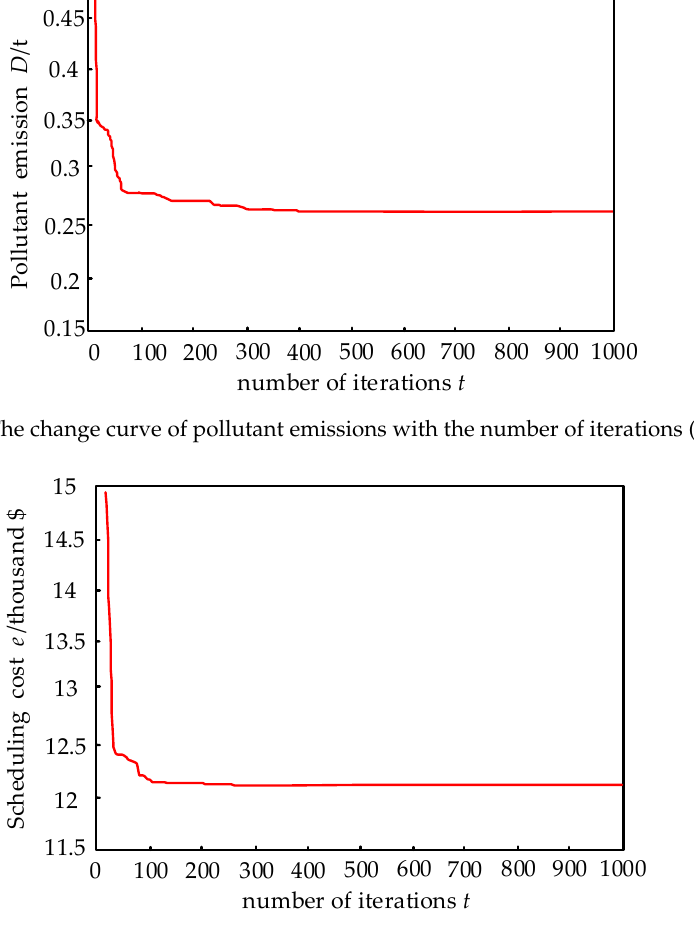
Figure 14. The change curve of pollutant emissions with the number of iterations (improved SPSO). Table 12. Comparison of two algorithm scheduling results. Comparison of Results